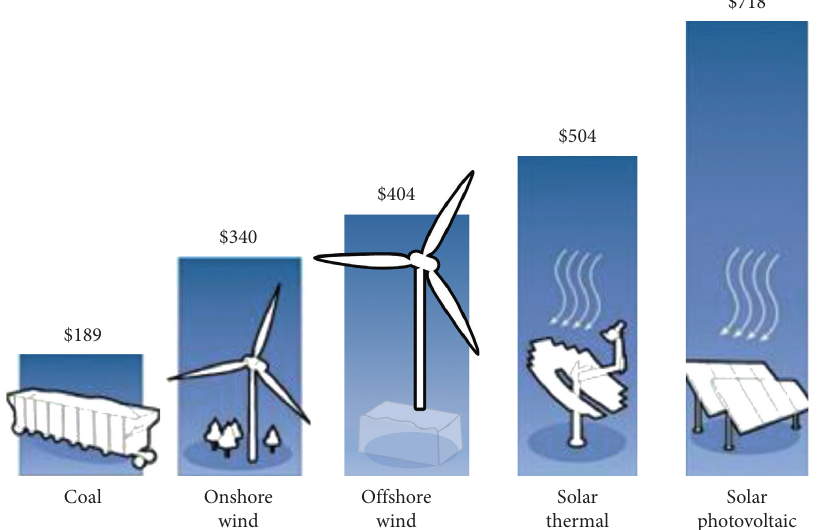
Figure 2: Variance of the price in alternative energy.